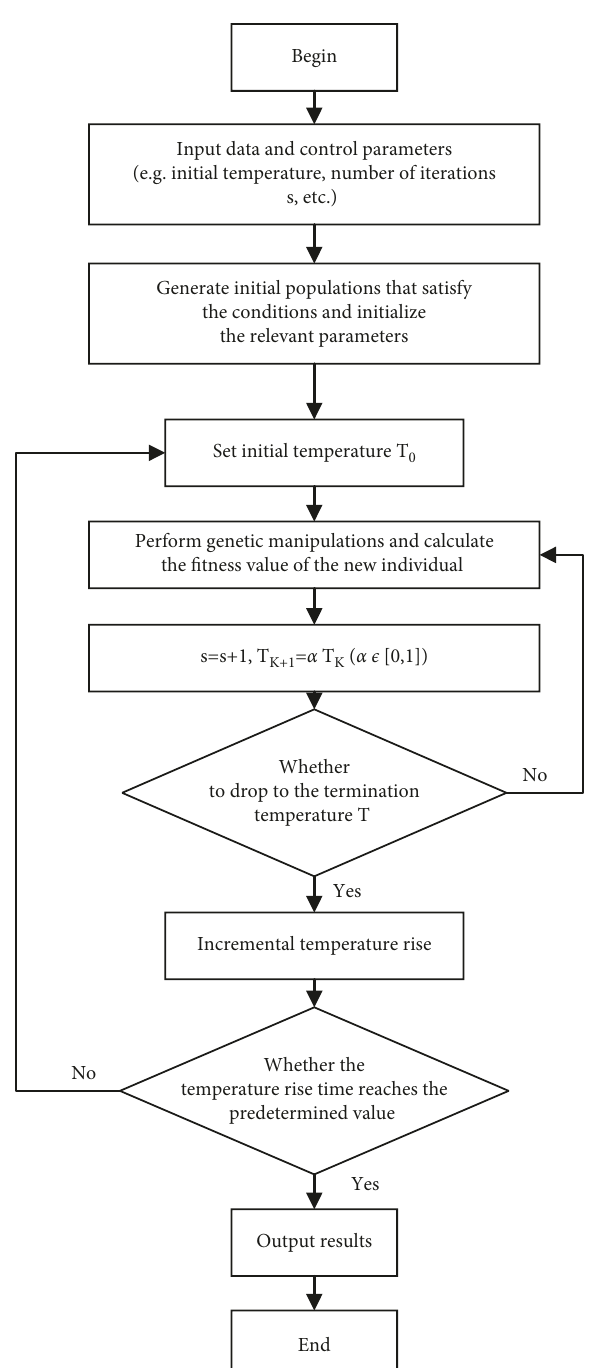
Figure 6: Flowchart of the simulated annealing-genetic hybrid